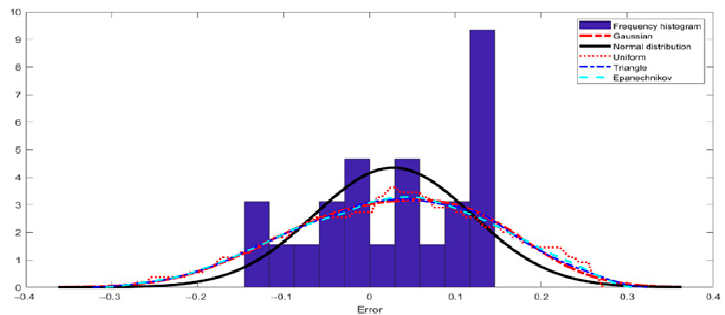
Figure 4. Kernel density estimation results.